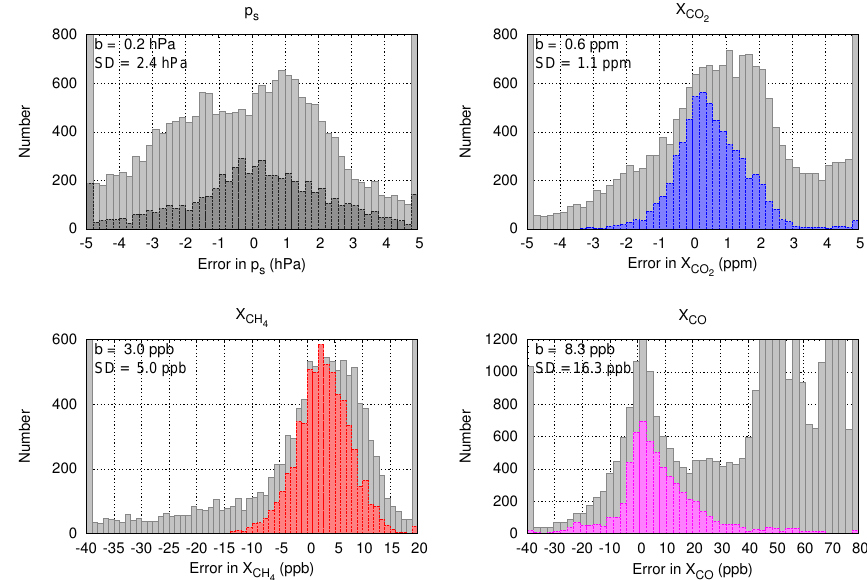
, X CH and X CO for experiment 3 with cloud-enabled and regionally 2 4